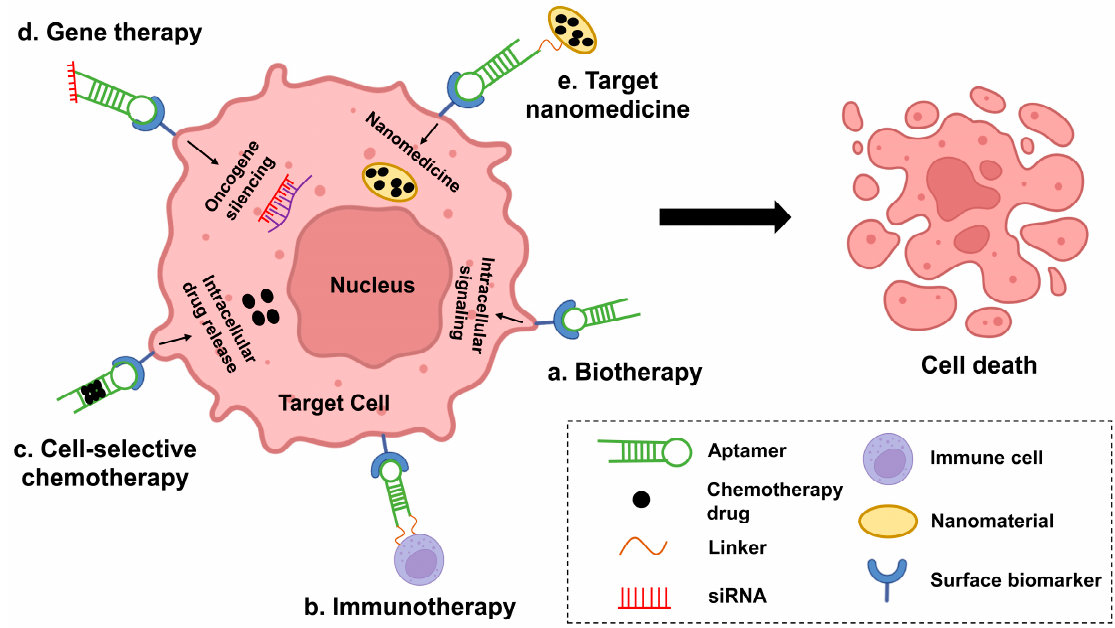
Figure 2. Aptamer-mediated five major tumor treatment options. ( a ). Biotherapy: Aptamers recognize and bind to cell membrane surface targets, internalize into cells, and exert anticancer activity by activating or inhibiting relevant intracellular signaling pathways. ( b ). Immunotherapy: By coupling the aptamer to immune cells, immune cells target recognition and bind to target cells for immune activity. ( c ). Cell-selective chemotherapy: Aptamer-drug couples recognize and bind to target membrane proteins of cancer cells, and after internalization, chemotherapeutic drugs are released intracellularly for efficient activity. ( d ). Gene therapy: Aptamer-siRNA couples recognize and bind to the target membrane proteins of cancer cells, and after entering the cells siRNA exerts anti- cancer activity by silencing the expression of oncogenes within the cells. ( e ). Target